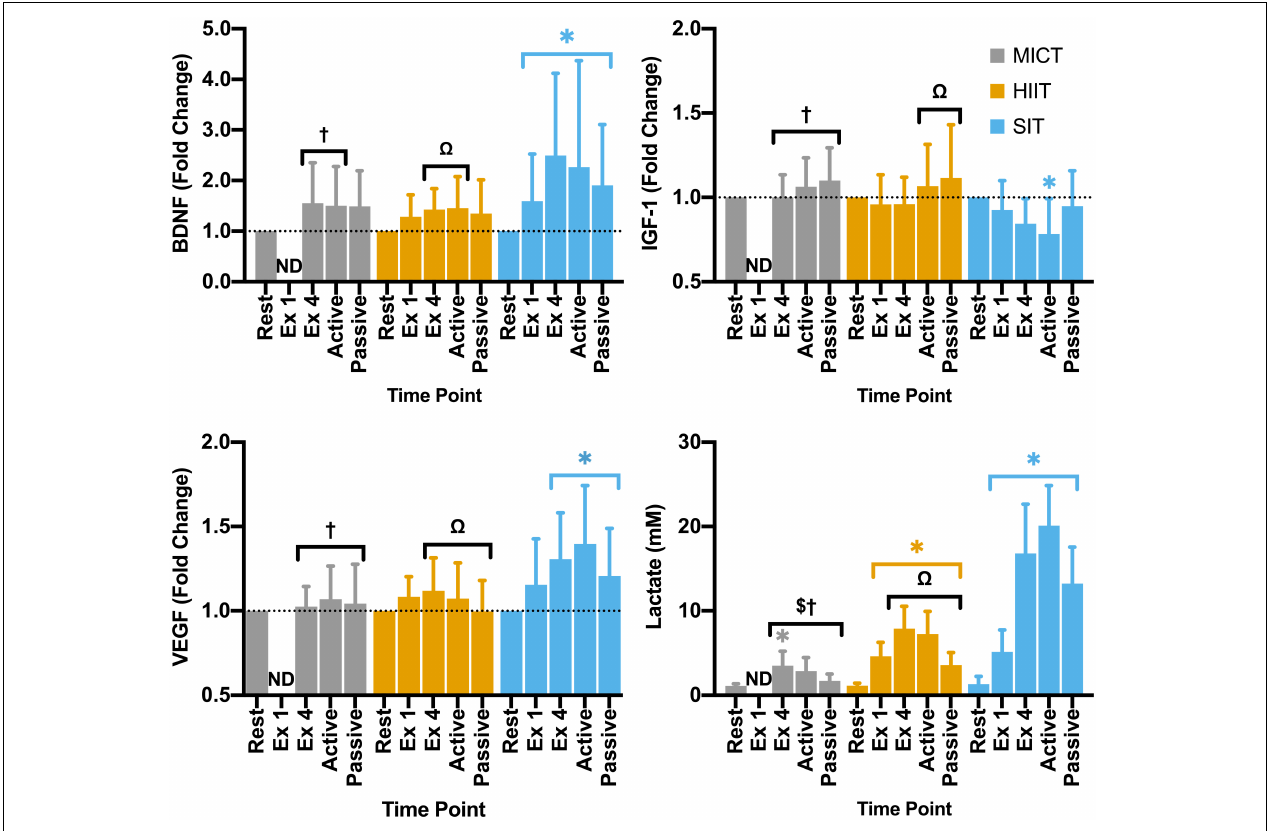
FIGURE 5 | Blood plasma samples were taken during seated rest (Rest); immediately after the first interval exercise bout (Ex 1; HIIT and SIT only); at the end of exercise (Ex 4, end of active recovery (Active); and the end of passive recovery (Passive). Brain-derived neurotrophic factor (BDNF; n = 21), insulin-like growth factor 1 (IGF-1; n = 17), and vascular endothelial growth factor [VEGF; n = 15 (14 in SIT)] were analyzed by ELISA. Blood lactate [ n = 24 (23 in SIT)] was analyzed using automated photometric analysis. Data are presented as mean ± SD . Significance (analyzed by linear mixed model, p < 0.05) between resting values and subsequent time points is denoted by * . Significant differences between protocols are denoted by $ between MICT and HIIT; † between MICT and SIT; and (cid:127) between HIIT and SIT. ND, not determined.